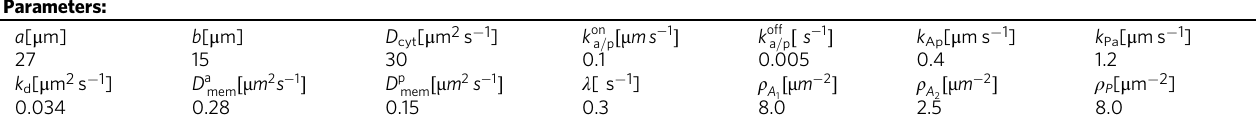
Figure3: Forthe sweep using linearstabilityanalysisinFig.3 c , allparameters but λ and D cyt werechosen as shown in this Table. λ wasvaried between5×10 − 3 s − 1 and0.35s − 1 witha uniformspacingof 5×10 − 3 s − 1 . D cyt wasvariedfrom6 μ m 2 s − 1 to38 μ m 2 s − 1 withauniformspacingof2 μ m 2 s − 1 .Figure4:ForthelinearstabilityanalysissweepinFig.4a,b,allparametersbut λ and k Ap and k Pa werechosen as above. k Ap was varied between 0.02 μ ms − 1 and 0.8 μ ms − 1 , and k Pa was varied between 0.06 μ ms − 1 and 1.6 μ ms − 1 ; for both parameters values were uniformly spaced with distance 0.02 μ ms − 1 . Figure5:ForthelinearstabilityanalysissweepsinFig.5,allparametersbutthedensities ρ A varied accordingly. The simultaneous sweep of ℓ and k Pa / k Ap was obtained by varying λ and k Pa for fi xed D cyt = 30 μ m 2 s − 1 and k Ap = 0.4 μ ms − 1 . The values of ℓ were uniformly spaced from 2 to 62 μ m with distance 2 μ m. The ratio k Pa / k Ap was varied from 0.7 to 8.0 with uniform steps of